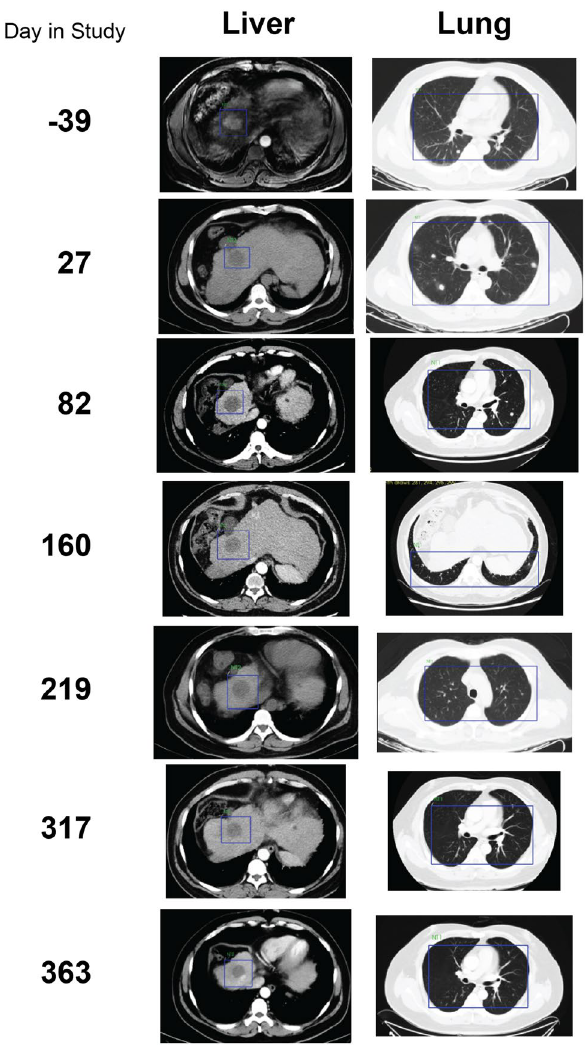
Figure 5. Regression of primary tumor and metastases in Patient 6. A primary tumor is visible in the liver prior to the study start (blue box, day -39) but only the tumor-free cavity remains in subsequent images throughout the course of the study. In the lung, multiple metastases present as white spots throughout the first 82 days of imaging but are undetectable by day 160 and remain so for the remainder of the study. All images are MRI with the exception of day −39 for the liver, which is